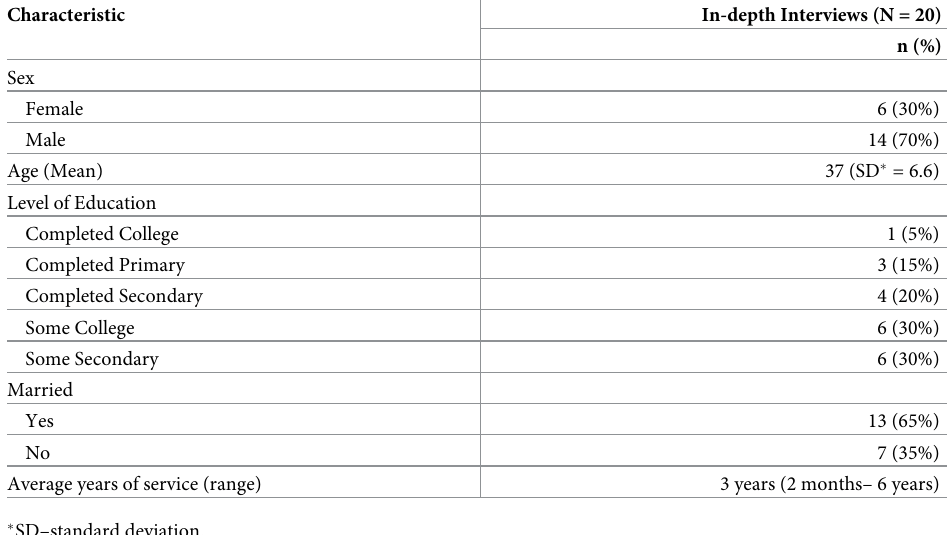
Table 1. Characteristics of study